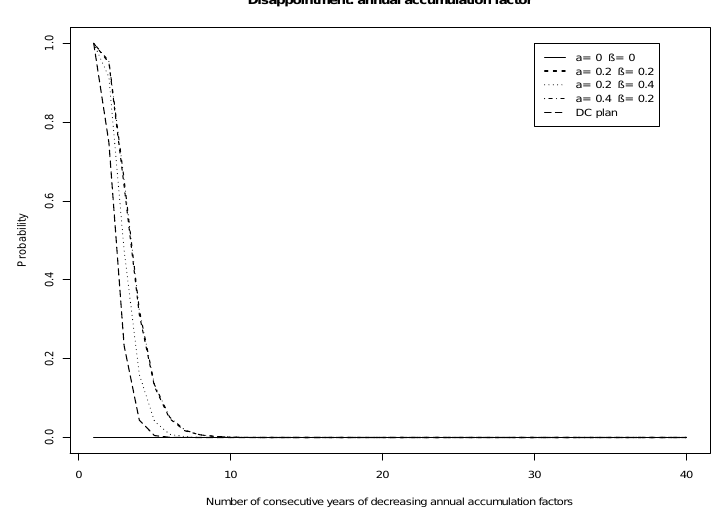
Figure 10. Disappointment for the more realistic membership when the target funding level ¯ F = 120%. The probability of a declining AAF plotted against the number of consecutive years that the decline occurs over. Both the investment risk adjustment ( a ) and the AAF adjustment ( b ) are